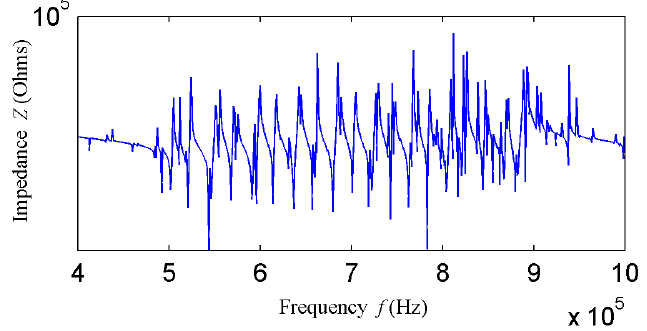
Figure 3. A schematic diagram of multiple resonant coupling theory.